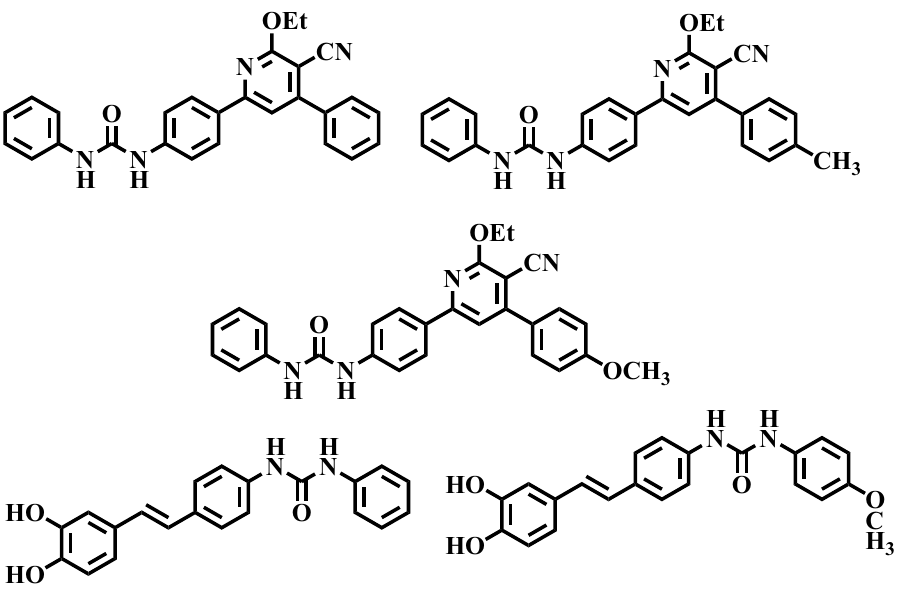
Figure 1. The available reported α-glucosidase inhibitors 18,19